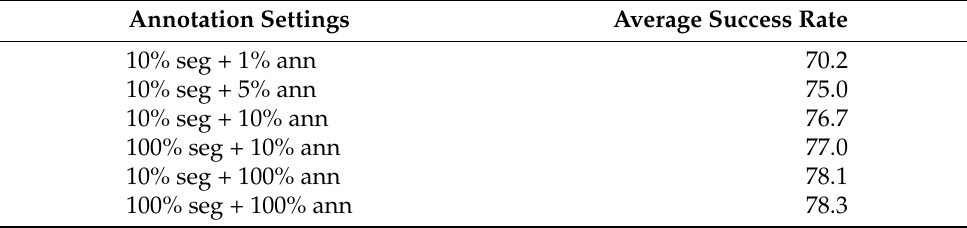
Figure 4. Offline subtask success rate v exact . The amount of annotated trajectories denotes the fraction of trajectories of all annotated trajectories. The dashed lines illustrate the performance of models that use 100% of annotated trajectories. Table 4. Offline success rate v exact of SLHSP learned with different training data